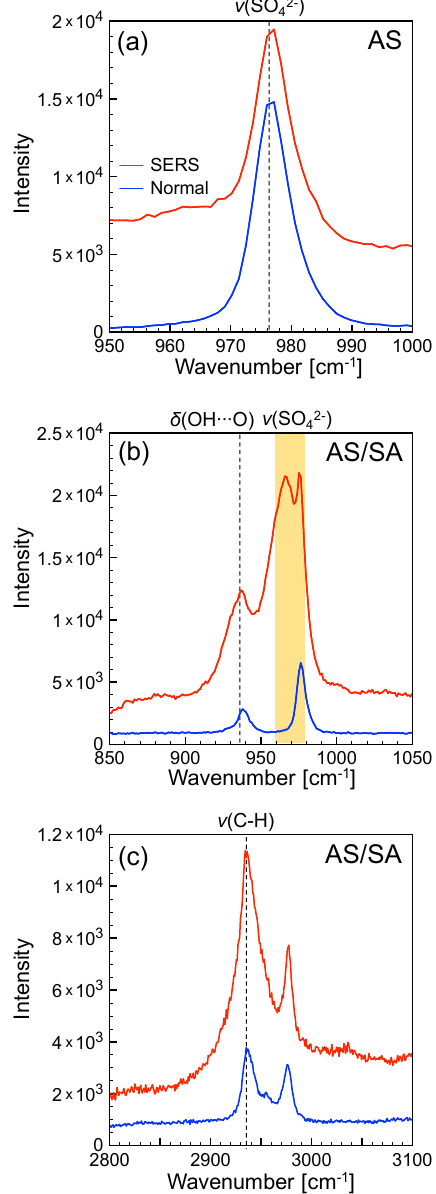
Figure 5. Normal and SERS spectra for (a) AS and (b) AS / SA particles at v (SO 2 − ) and (c) v (C–H) (only applicable to the AS / SA 4 particles)